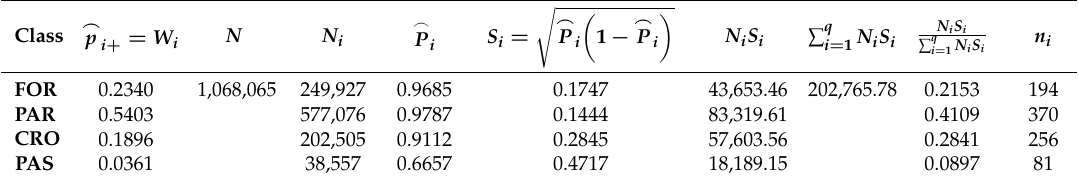
Table 8. Neyman optimal allocation of the sample in each stratum, when the total number of samples is n = 900 a .